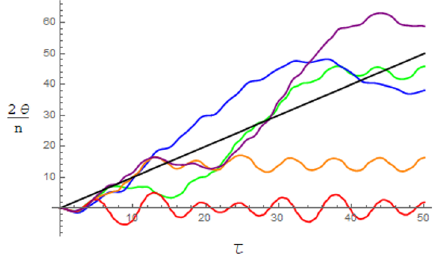
Figure 5 . The driven motion observed for di(cid:11)erent n , where n = 2 (Blue), 3 (Purple), 4 (Green), 4.5 (Orange), 8 (Red) while the black line corresponds to _ (cid:18) = ( n= 2) (cid:22) inf , and (cid:28) = (cid:22) inf ( t (cid:0) t d ); where we have considered eq. (5.50) and